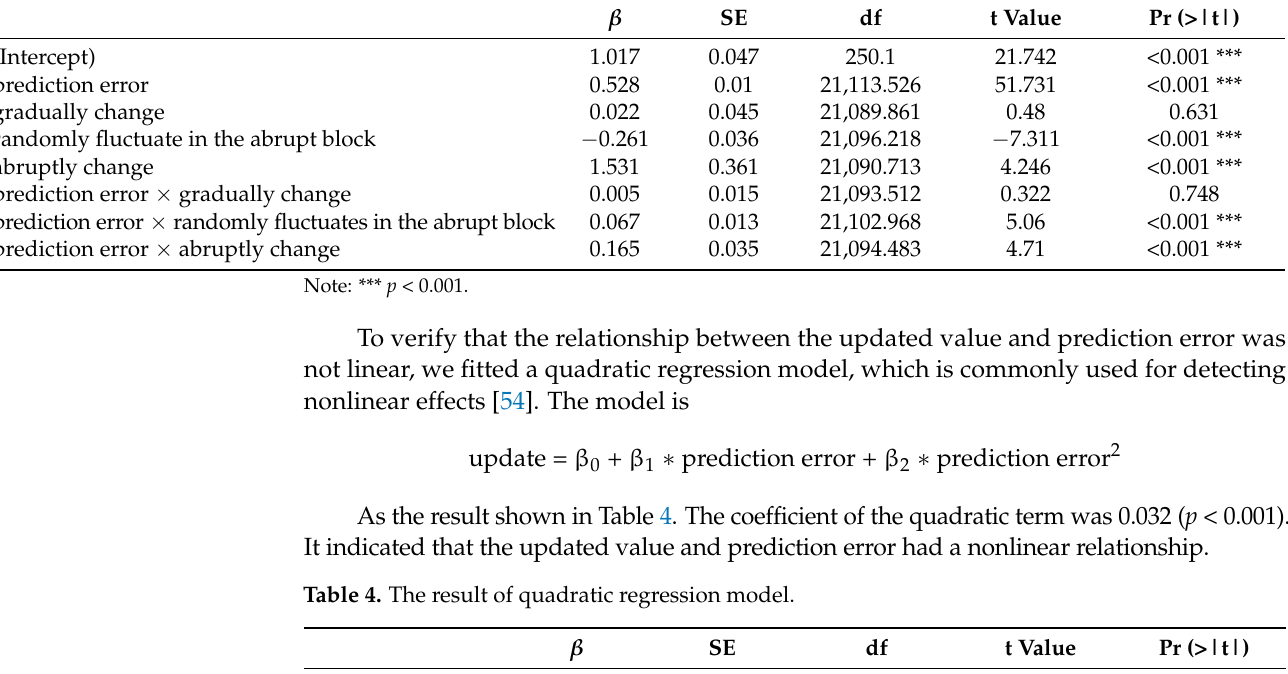
Table 3. The learning rate in the gradually changed block and the abruptly changed block: Results of mixed-linear model. β